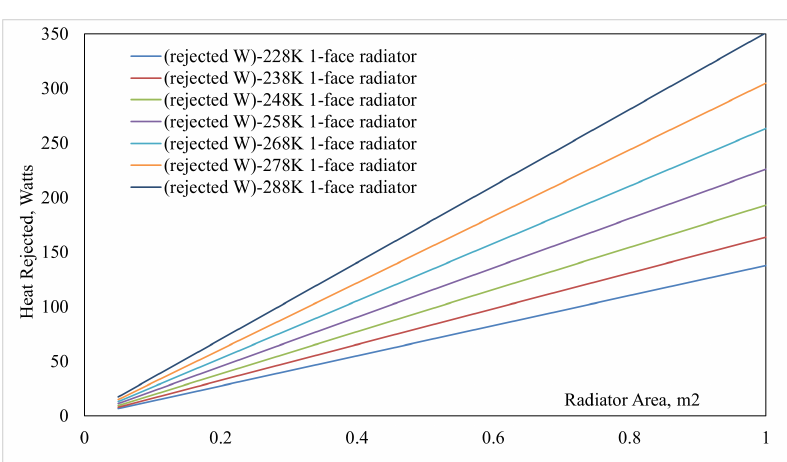
Figure 7. Heat rejection with temperature.